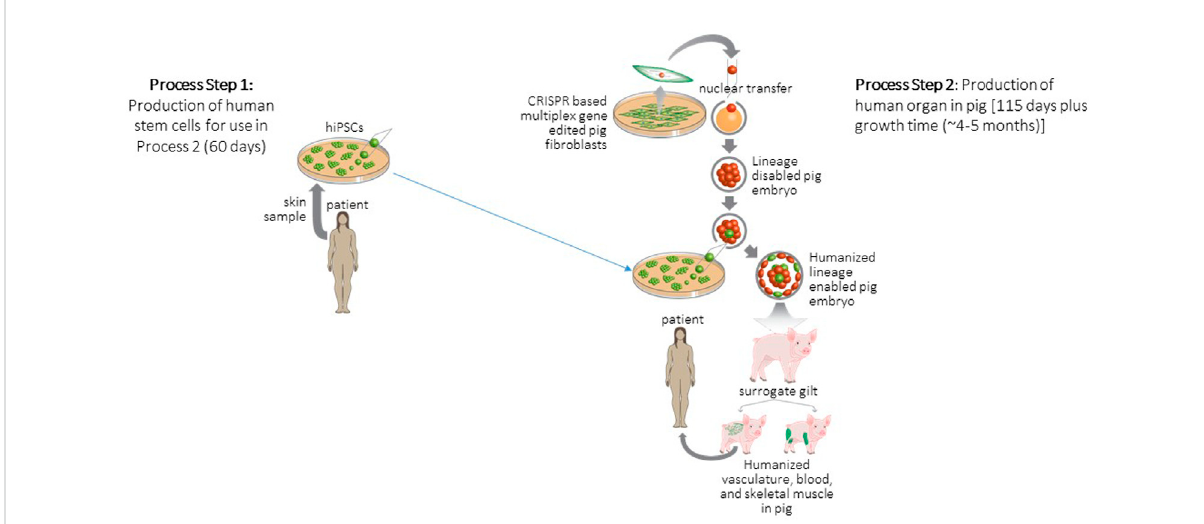
FIGURE 2 Strategy for generation and transplantation of human organ engineered in pig. Process Step 1: Biopsies are collected from patients to derive hiPSCs. Process Step 2: Porcine embryonic fi broblasts are gene edited to delete a lineage following which these fi broblasts are cloned to produce null porcine embryos. Blastocyst complementation is used to deliver patient derived hiPSCs to null embryos following which the complemented embryos aresurgicallytransferredto asurrogate animal.The offspring ofthesurrogate develops ahumanorgan to replacethedeletedlineage. These human organs are then harvested and transplanted to the patient. Figure modi fi ed from (Garry and Garry,